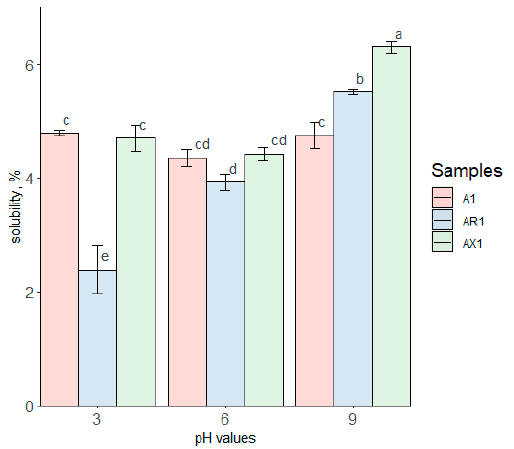
Figure 5. Protein solubility among the oat protein samples A1, AR1, and AX1 at pH 3, 6, and 9; %. Different letters indicate significant differences within the samples ( p <